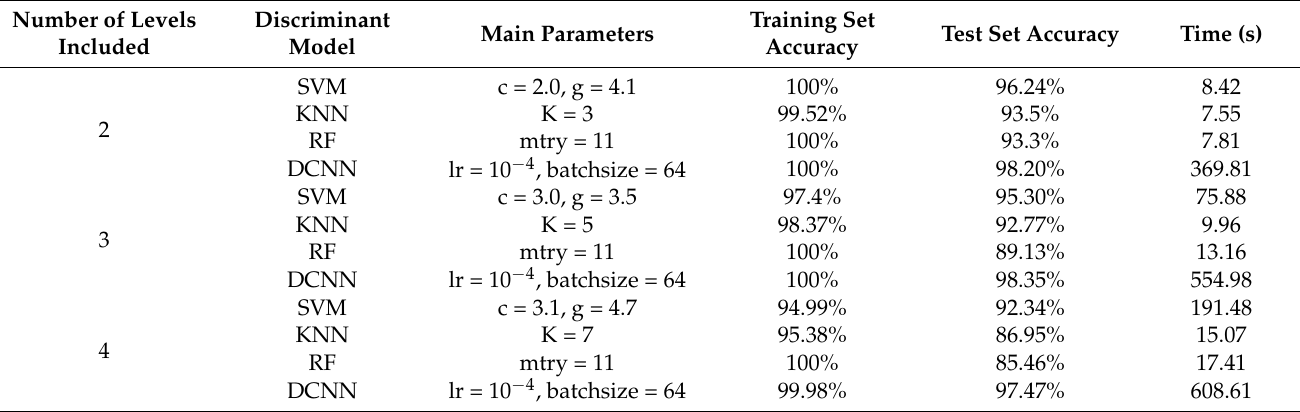
Table 3. Identification results of waxy corn seed viability by different discrimination models in the whole